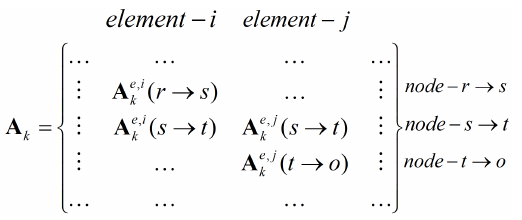
Figure 3. The assembly method for the mixed-nodal-element assemblage.